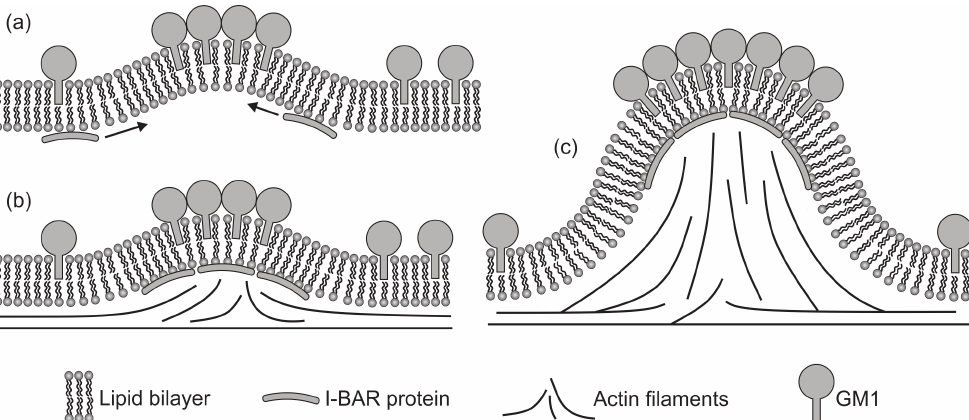
Figure 22. Schematic diagram of the possible mechanism of the membrane protrusion growth. ( a ) GM1 aggregates/nanodomains with positive intrinsic curvature and I-BAR protein domains generate the initial plasma membrane outward deformation. ( b ) More I-BAR domains are attracted to the negative curvature region at the inner leaflet of the membrane. They accumulate and partially support the initial protrusion. Actin filaments start to fill the space inside the initial protrusion through stochastic polymerization. ( c ) I-BAR domain proteins bend the membrane further, while actin filaments are filling the space inside the protrusion. The nucleation of actin filaments drives the membrane protrusive growth, elongating or stabilizing the membrane protrusion. Adapted with permission from ref. [71]. 2011 Dove